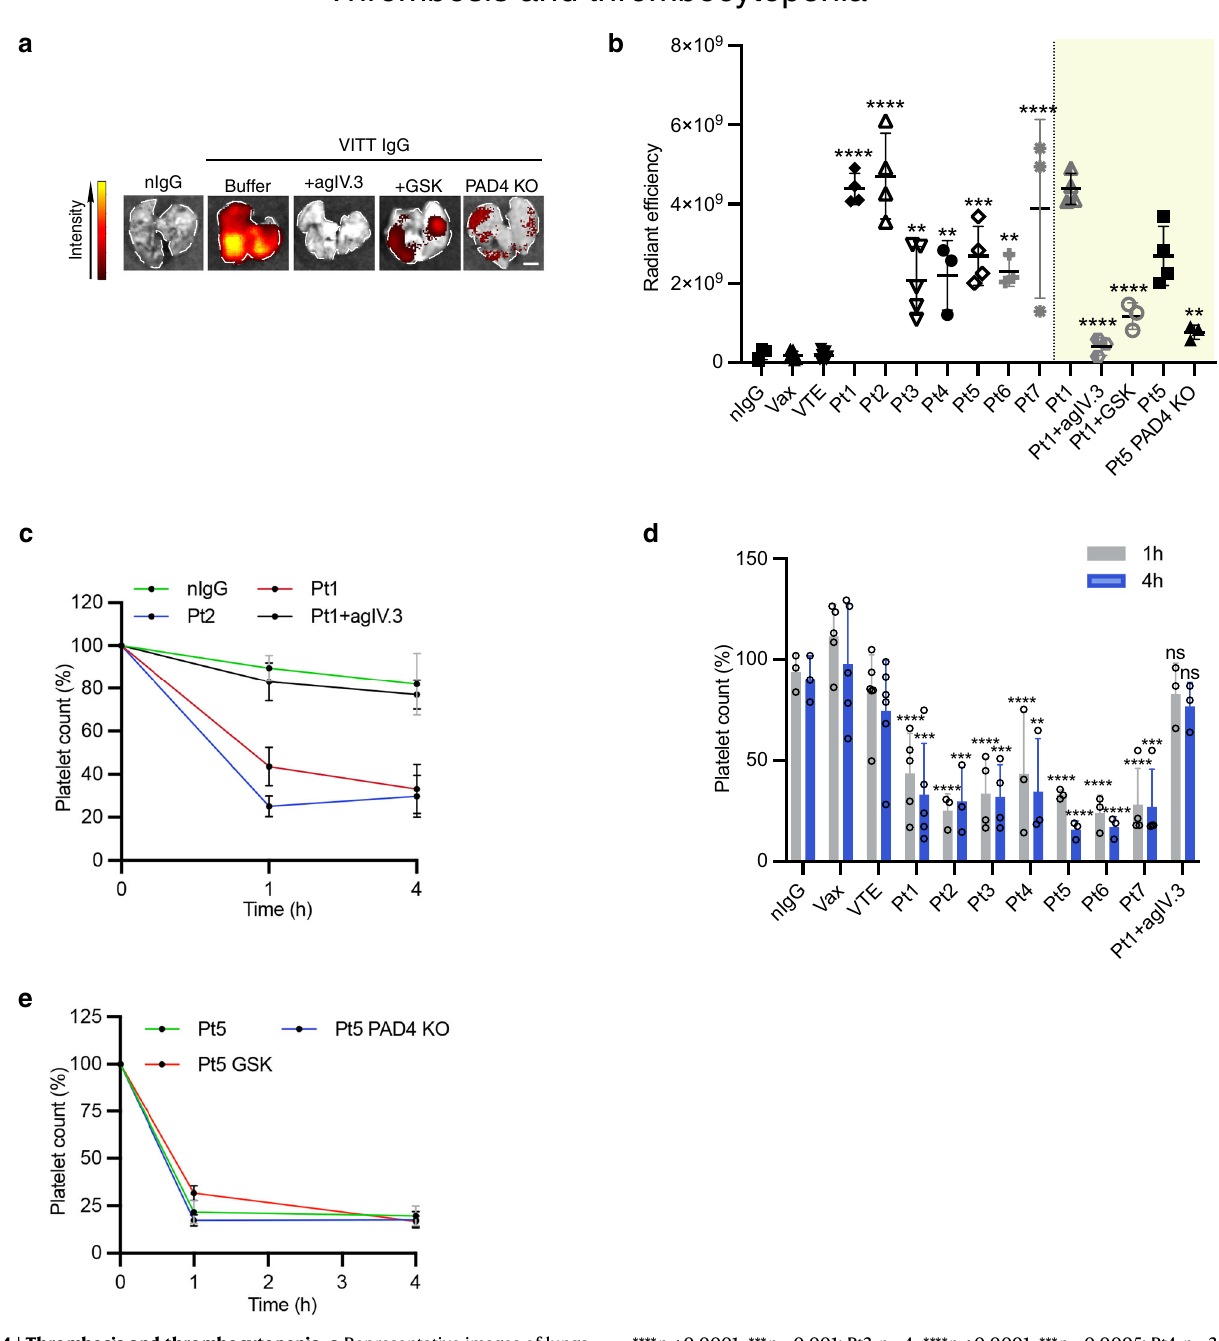
Fig. 4 | Thrombosis and thrombocytopenia. a Representative images of lungs following treatment. The level of fl uorescence indicates accumulation of platelets labelled with anti-CD42c-Dylight 649 in the lungs. Scale bar: 2.5mm. b Graph of lung fl uorescence for the VITT patients indicated (nIgG n =3; Vax n =7; VTE n =8;